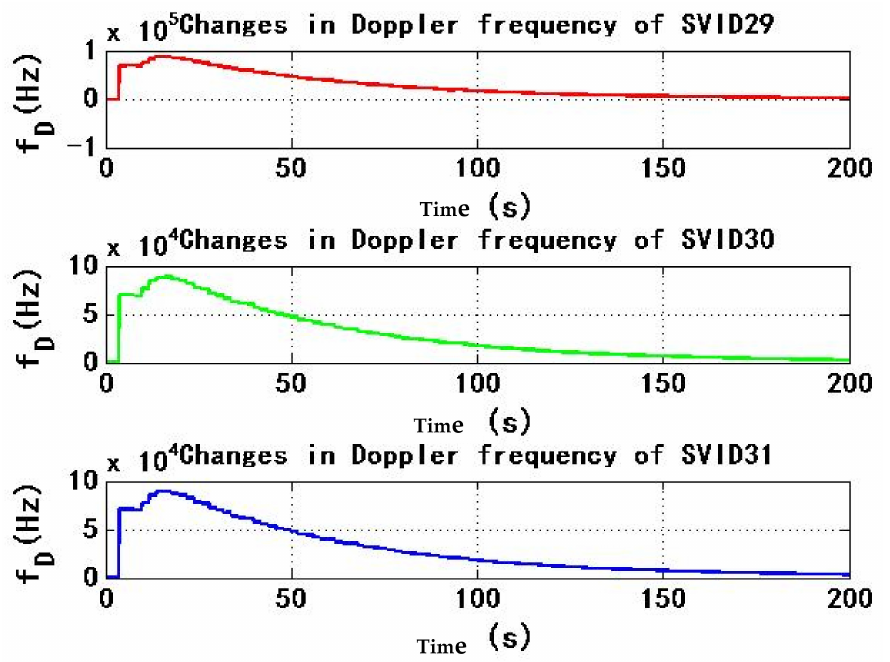
Figure 8. Changes in Doppler frequency of SVID29, 30, 31 in experiment 1.